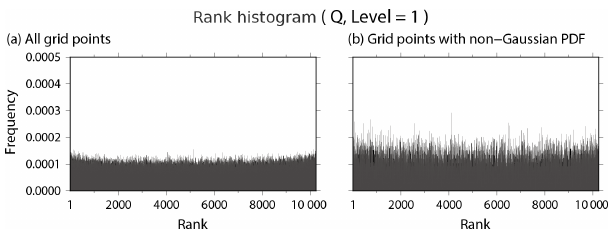
Figure 19. Rank histograms verified against truth for background specific humidity at the lowest model level ( ∼ 925hPa) at (a) all grid points and (b) the grid points with non-Gaussian PDF from 00:00UTC on 25 January to 18:00UTC on 1 March.